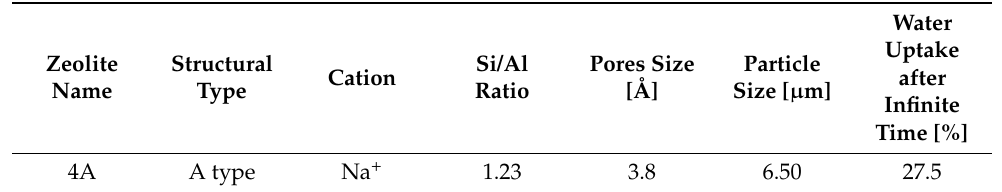
Table 1. Main characteristics of zeolites